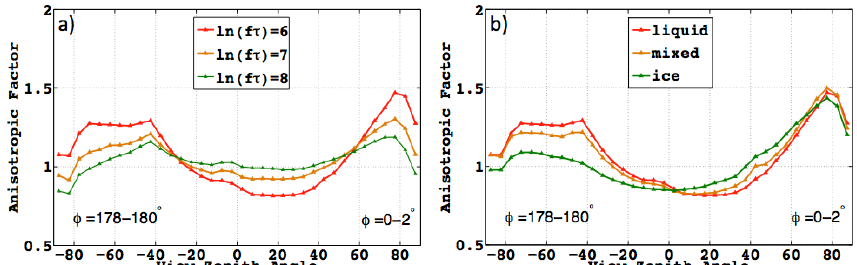
Figure 10. CERES clear-sky SW anisotropic factors in the principal plane for a region centered at 49.5 ◦ N and − 119.5 ◦ W for January for Figure 9. CERES SW anisotropic factors over land in the principal plane for (a) liquid clouds with θ 0 = 70 ◦ for all available NDVI bins. The IGBP surface type for NDVI between 0.1 and 0.2 is fresh snow and the IGBP surface type for NDVI 46 different ln ( f ˜ τ ) values, (b) clouds of different phases with ln ( f ˜ τ ) =6. Anisotropic factors are derived for between 0.2 and 0.3 is evergreen needleleaf forest. Anisotropic factors are derived based upon 60 months of CERES Terra measurements θ 0 =40 ◦ -45 ◦ based upon 60 months of CERES Terra measurements. over clear CERES footprints.